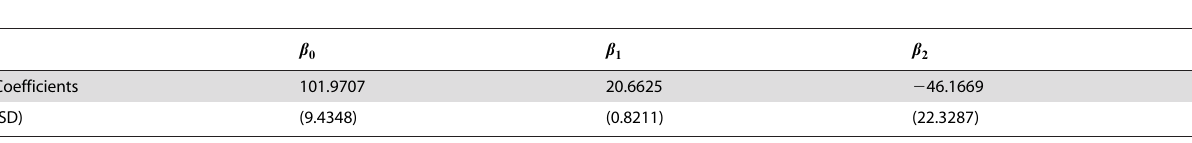
Table 6. Normal GSAM model fitted to SAR of Hymenoptera